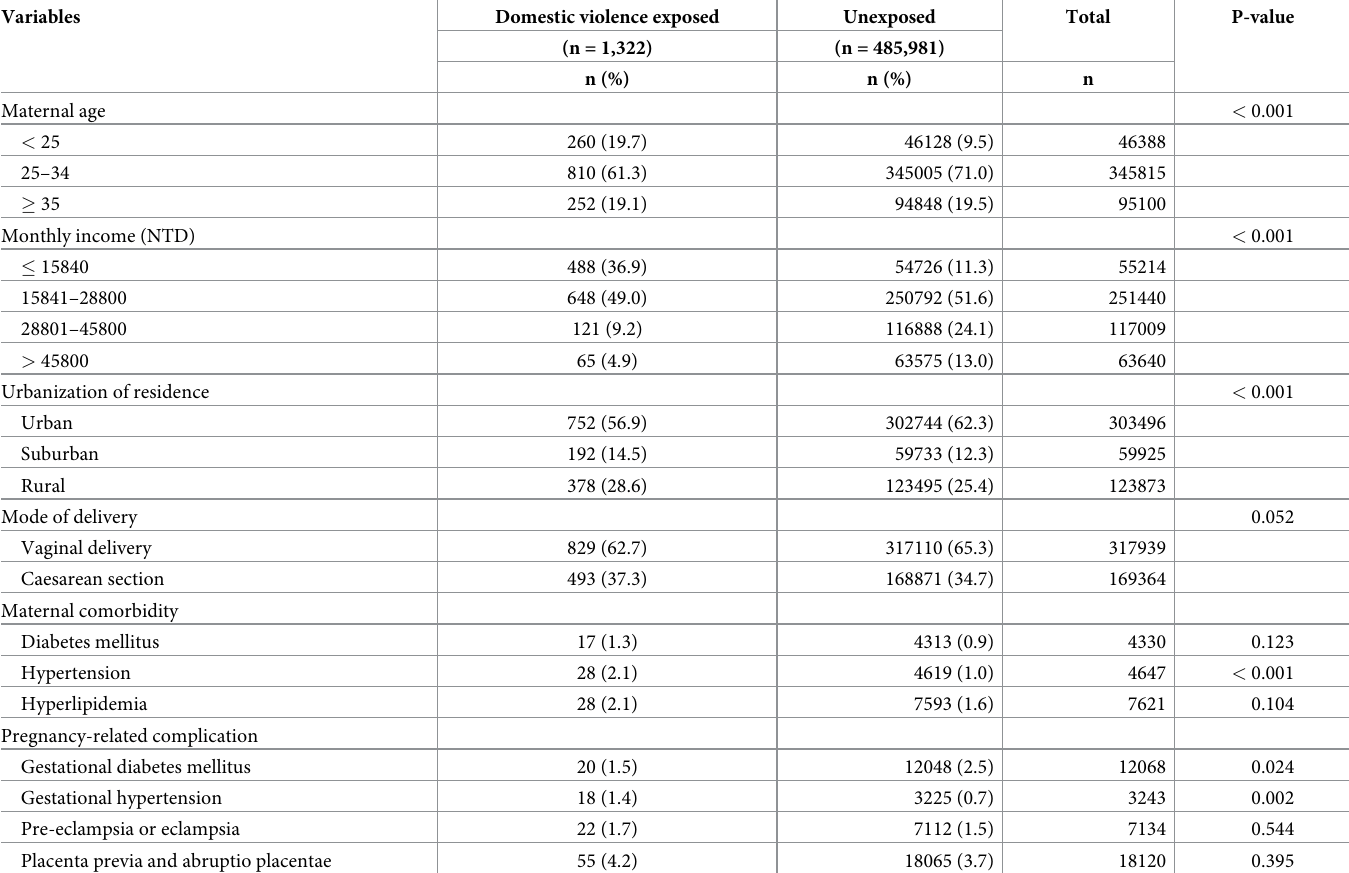
Table 1. Characteristics of study